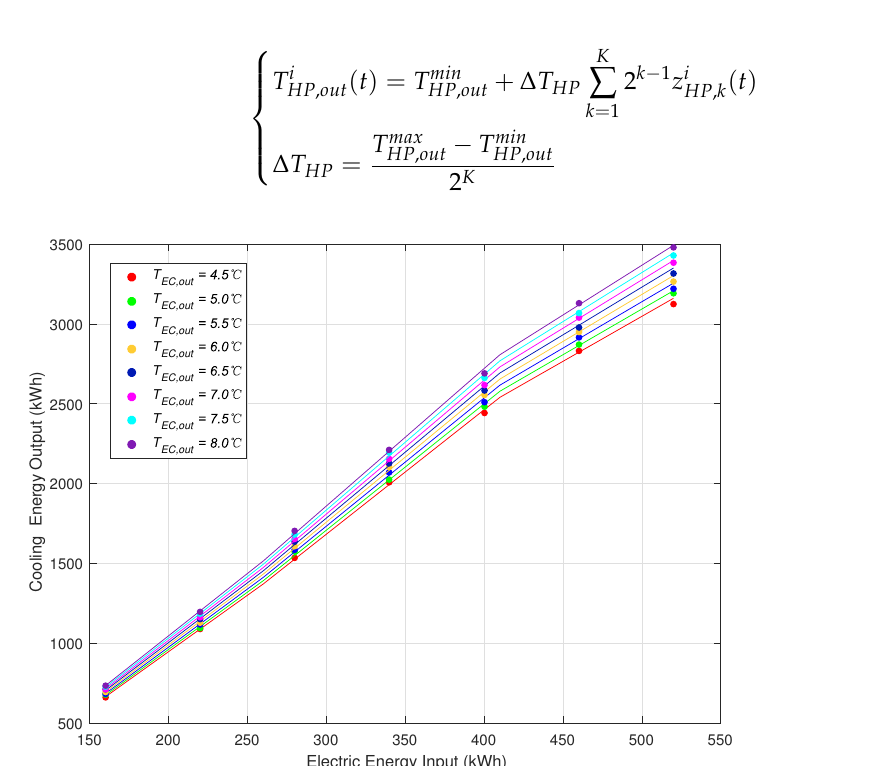
Figure 5. Diagram of cooling output and electric energy input under different T EC , out